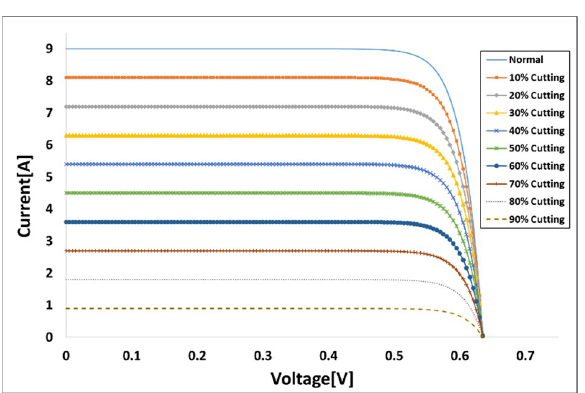
Figure 13. Current-voltage characteristic curve according to the cut area.